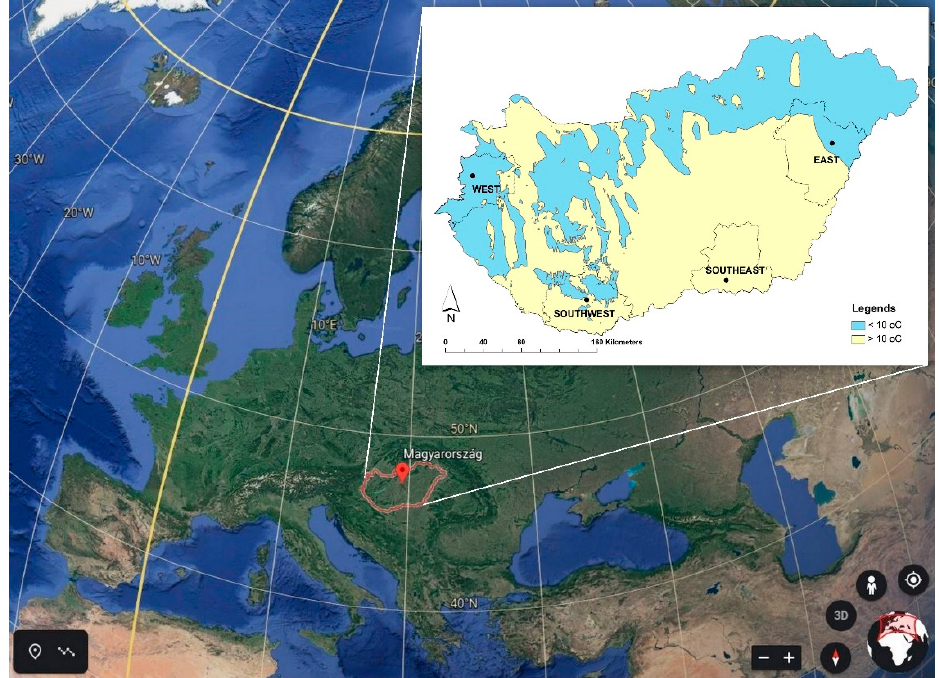
Figure 1. Location of the investigated regions in the two Intergovernmental Panel on Climate Change (IPCC) climate zones (mean annual temperature below and above 10 °C) of Hungary.